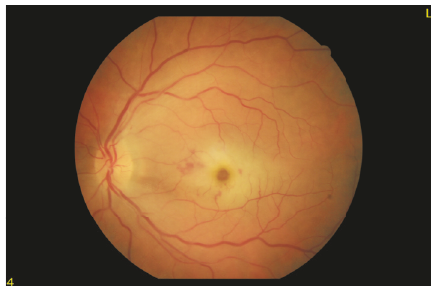
Figure 1: A cherryred spot in the macula in his left eye.